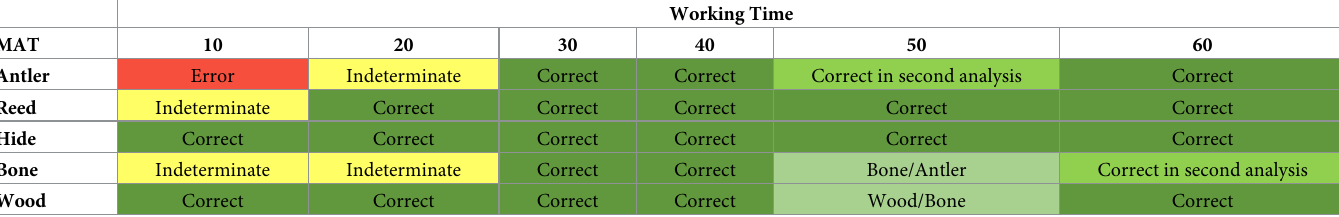
Table 6. Results of the blind classification of experimental tools per time of use when all the phases of use (from 10 to 60 minutes) are classified together in the five worked